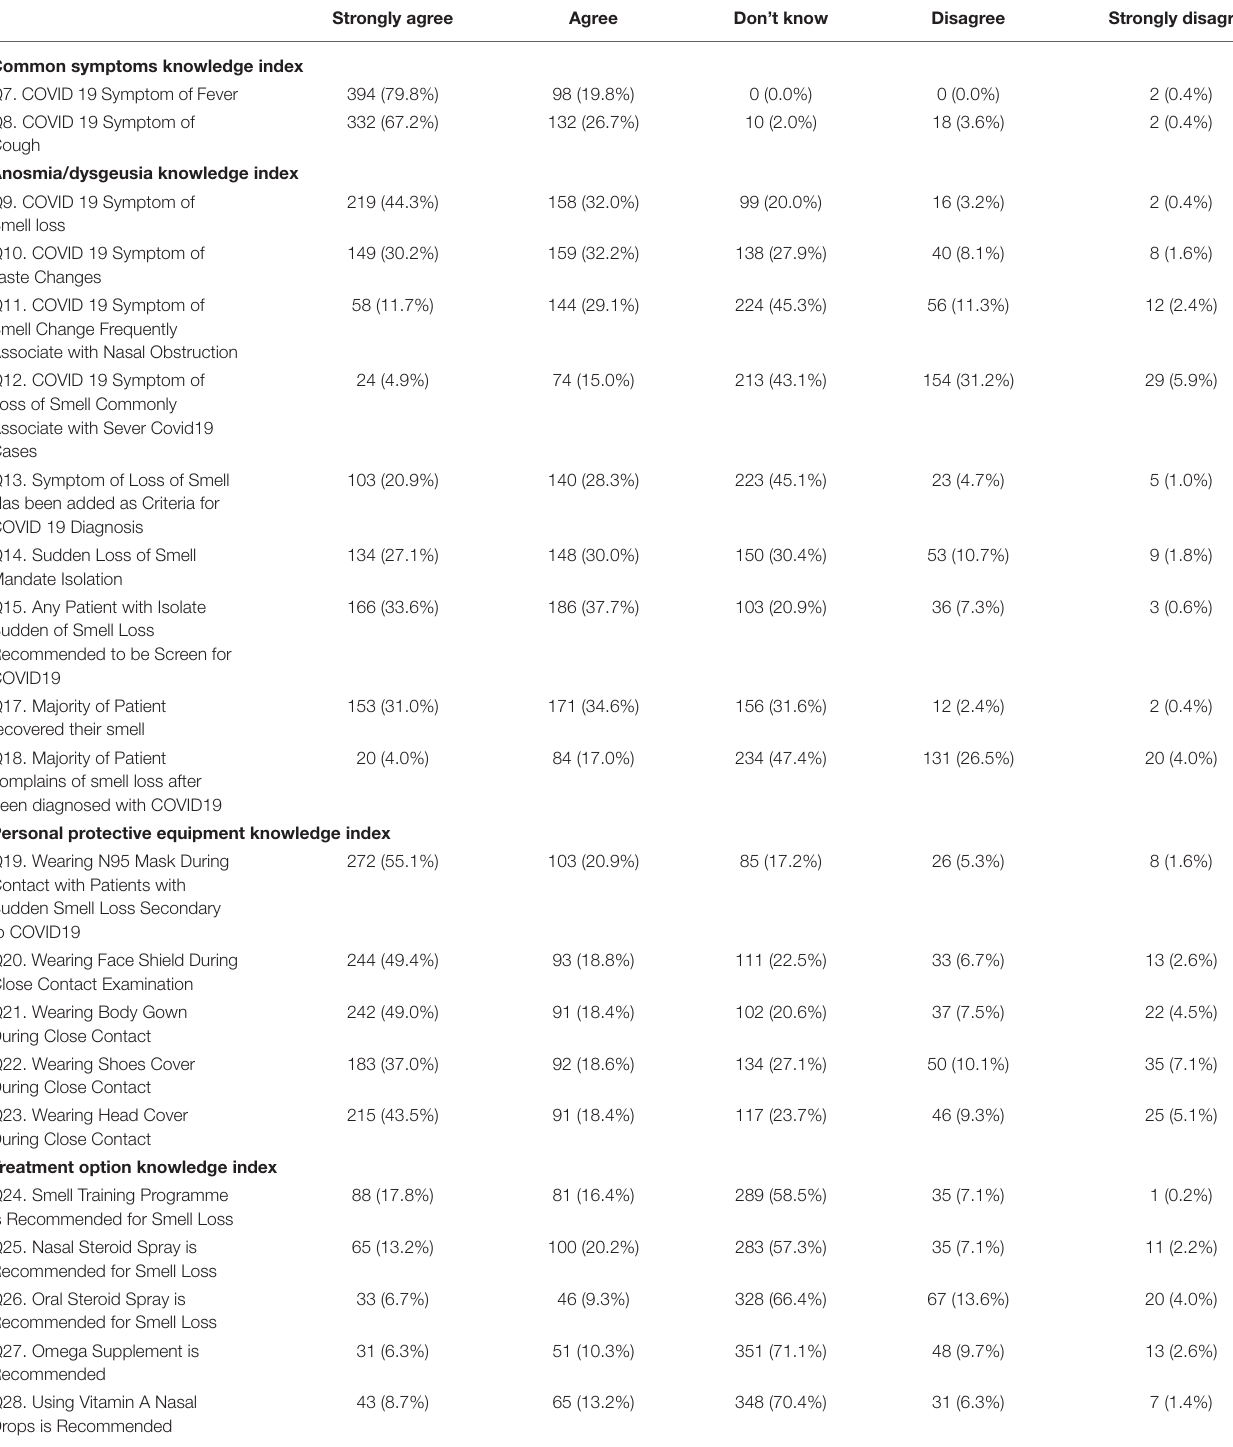
TABLE 2 | Frequencies and percentages of